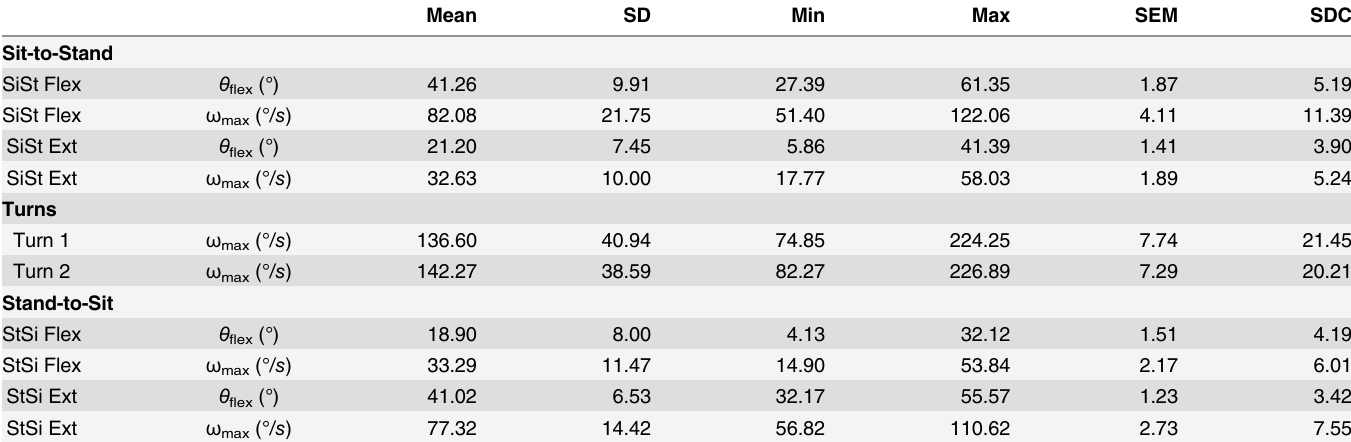
Table 3. Descriptive values, SEM and SDC of the angular range ( θ ) in degrees ( ° ) and the maximum angular velocity ( ω max ) in degrees per second ( °/s ) of the individual components of the